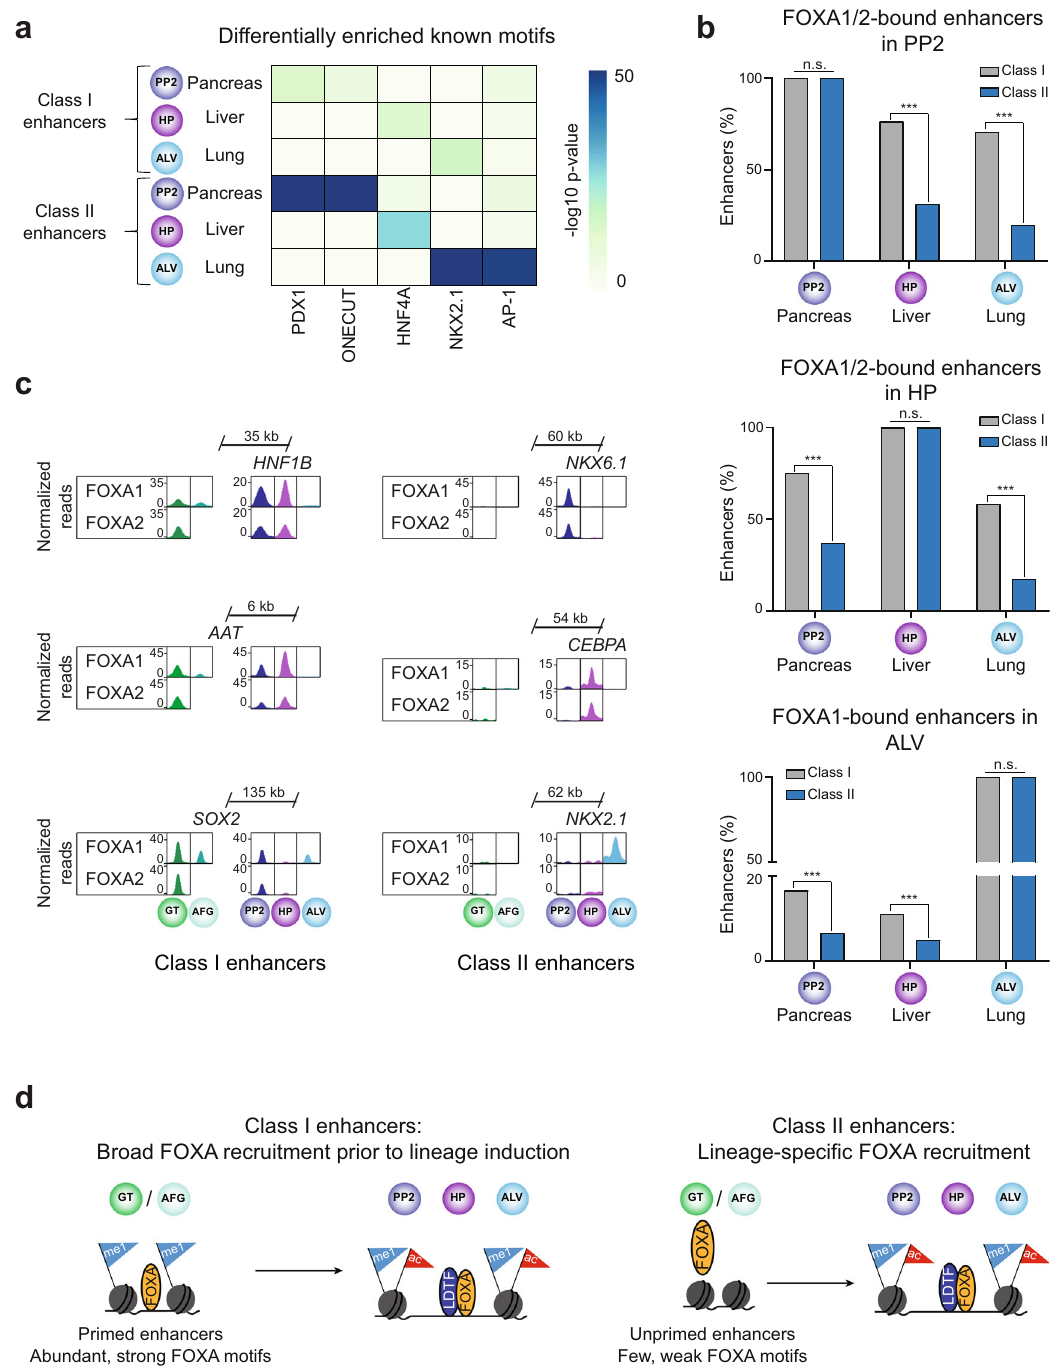
Fig. 8 Recruitment of FOXA1/2 to class II enhancers is lineage-speci fi c. a Heatmap showing enrichment of known binding motifs for lineage-determining transcription factors at pancreatic, hepatic, and alveolar class I and class II enhancers. Class I and class II enhancers of each lineage were compared against a background of class I and class II enhancers, respectively, of all other lineages. Fisher ’ s exact test, 1-sided, corrected for multiple comparisons. b Percentage of pancreatic, hepatic, and alveolar class I and class II enhancers overlapping FOXA1/2 ChIP-seq peaks (within 100 bp from peak) in PP2 (pancreas), HP (liver) and ALV (lung). For ALV only FOXA1 peaks were considered. P = 1, <2.2 × 10 − 16 , <2.2 × 10 − 16 , <2.2 × 10 − 16 , 1, <2.2 × 10 − 16 , 5.86 × 10 − 11 , 3.08 × 10 − 5 , and 1 for comparisons of FOXA occupancy at class I and class II pancreatic, hepatic, and alveolar enhancers at PP2, HP, and ALV stage cells, respectively; Fisher ’ s exact test, 2-sided). c Genome browser snapshots showing FOXA1/2 ChIP-seq signal across endodermal lineages at example pancreatic, hepatic, and alveolar class I and class II enhancers. Approximate distance between enhancer and gene body is indicated. d Schematic showing differential recruitment of FOXA TFs to endodermal organ class I and class II enhancers during endoderm development. LDTF, lineage-determining transcription factor. All ChIP-seq experiments, n = 2 replicates from independent